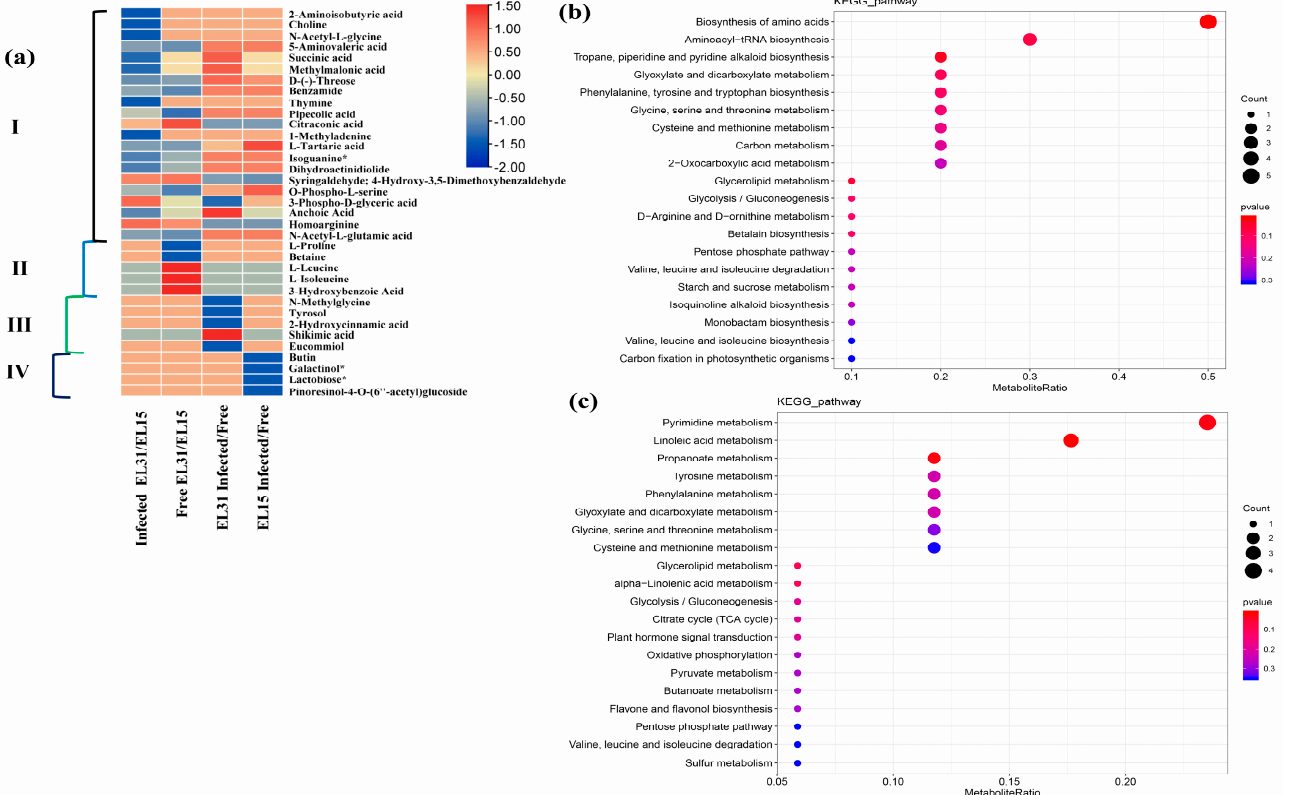
Figure 8. Analysis of differentially expressed metabolites (DEMs) in leaves. ( a ) Metabolites with significant increases or decreases in at least one of the comparisons. The four clusters(I–IV) represent the respective response patterns (Table S16). A small fraction of metabolites was selected from each cluster. ( b ) Top 20 enrichment pathways on the basis of KEGG analysis of the total DEMs between GFabV–infected and GFabV–free leaves at EL15; ( c ) KEGG annotation of top 20 DEMs at EL31. The size of bubble represents the number of metabolites in the pathway, the color represents the P value.